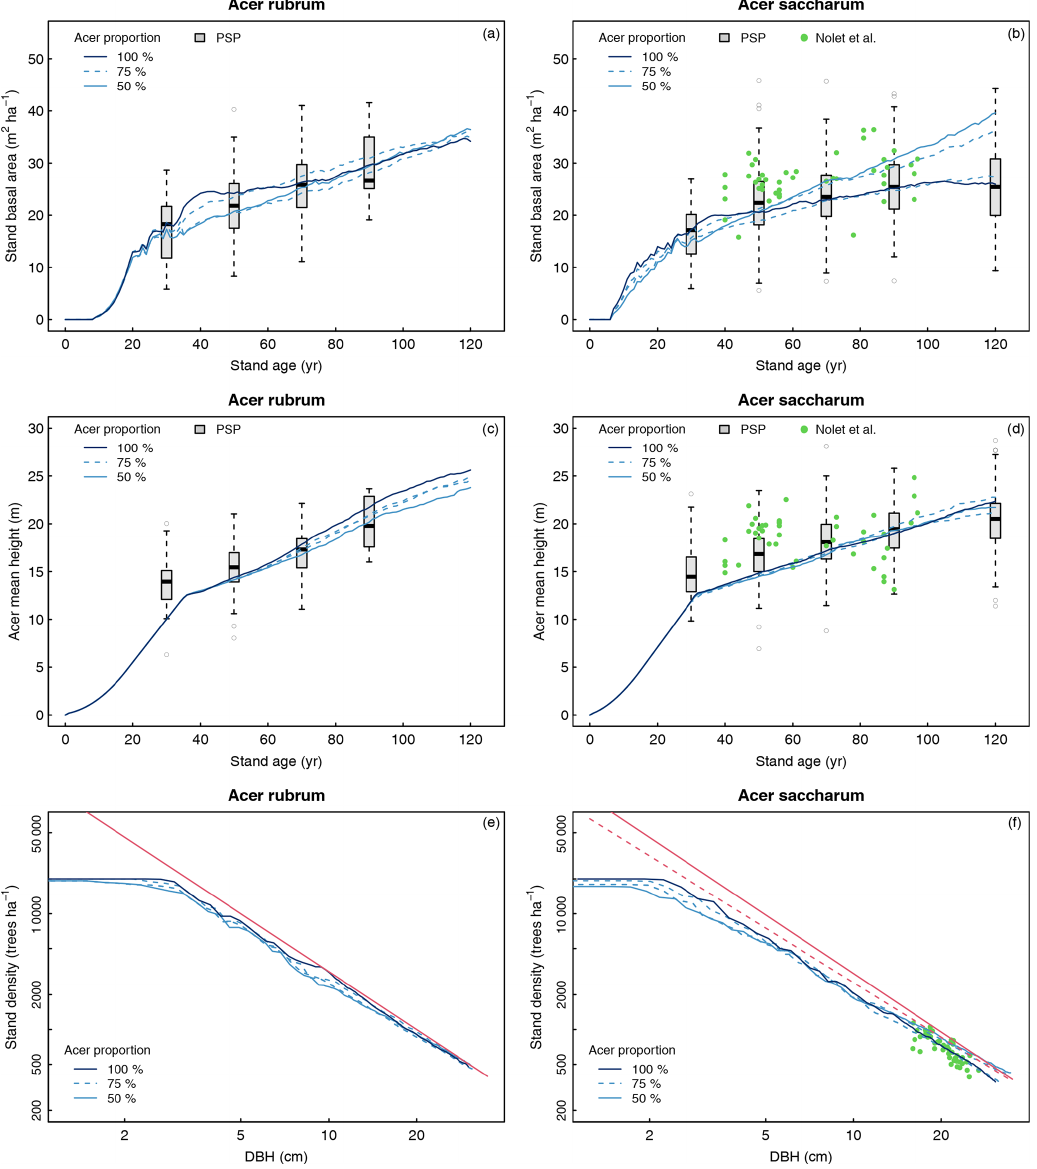
Figure 6. Evaluation of stand basal area (a, b) , mean height of maple species (c, d) , and stand density (e, f) over 120 years for stands dominated by Acer rubrum (a, c, e) or Acer saccharum (b, d, f) . The red line represents the self-thinning curves of Andrews et al. (2018), and the dashed red line represents the self-thinning line of Lhotka and Loewenstein (2008). PSP refers to permanent sample plot of the forest inventory of Quebec. Stand ages in the PSP dataset are grouped into 20-year classes (e.g., age class 30 refers to stands between 21 and 40 years), except for age class 120 (stands > 100 years). The green dots in panels (b) , (d) , and (f) are from Nolet et al. (2010). Acer proportion corresponds to the initial proportion of maple in the regeneration used in the four different simulations: (i) 100% maple, (ii) 75% maple